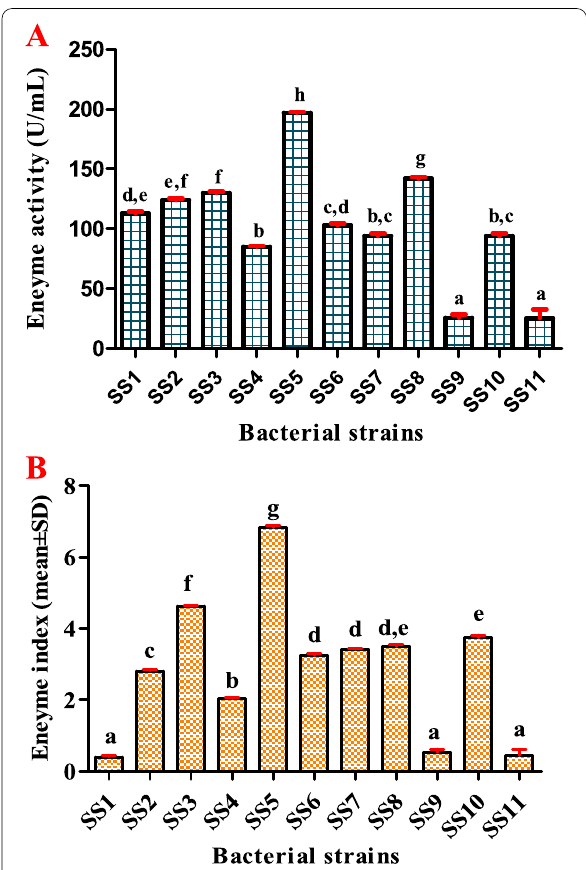
Fig. 1 Quantitative analysis of protease enzymes producing bacterial strains ( A ); enzyme index ( B